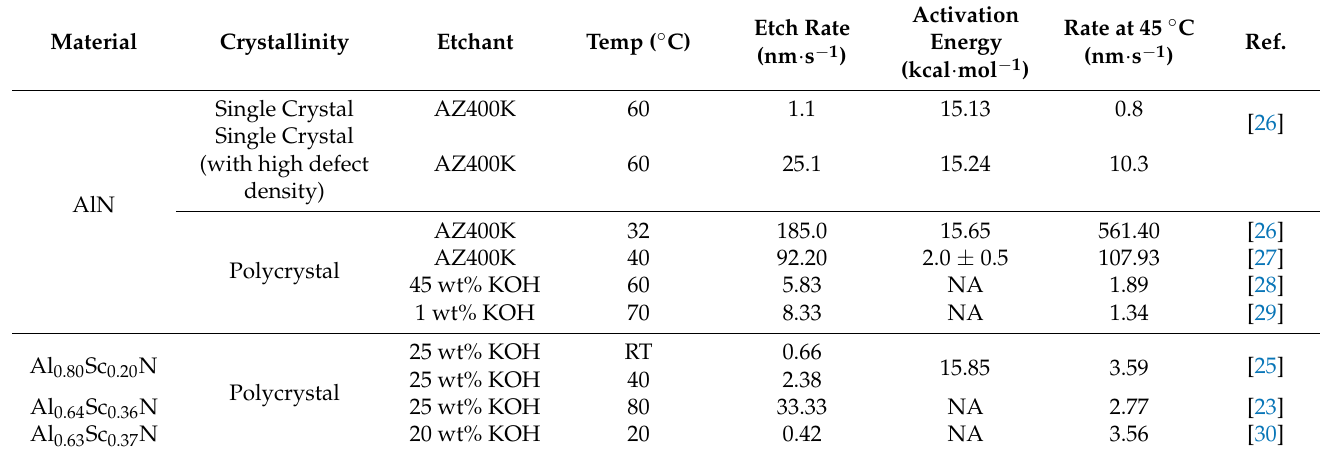
Table 2. Published vertical etch rates of AlN/Al 1 − x Sc x N in aqueous KOH